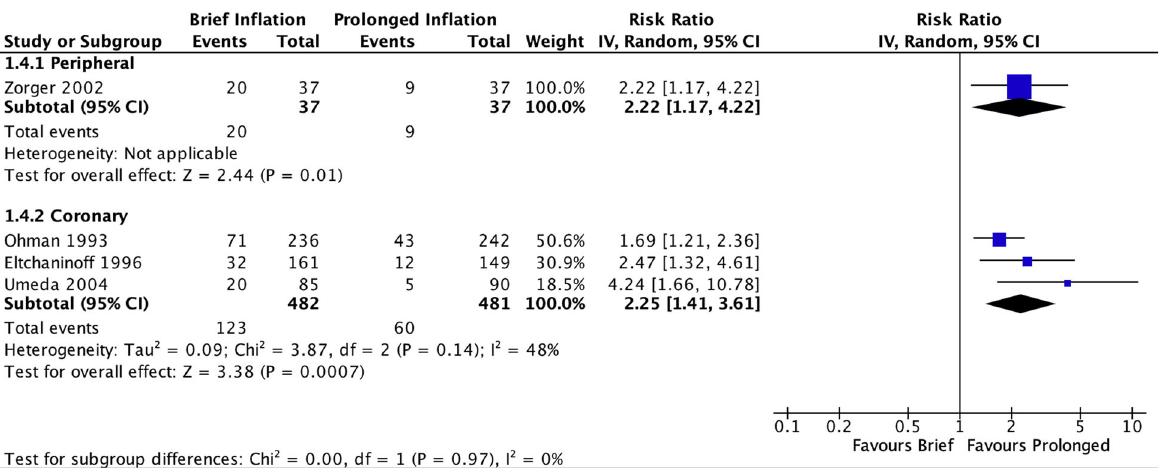
Fig. 6 Risk of receiving adjunctive procedures performed after initial inflation, during the same operative setting